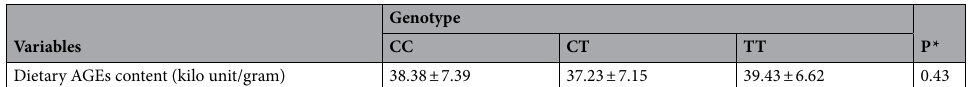
Table 4. Comparison of dietary AGEs content in different FADS2 genotypes. * P values based on One-Way ANOVA.